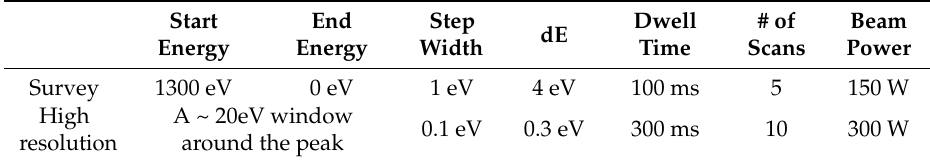
Table 2. Acquisition parameters for survey and high resolution X-ray photoelectron spectrometer (XPS)